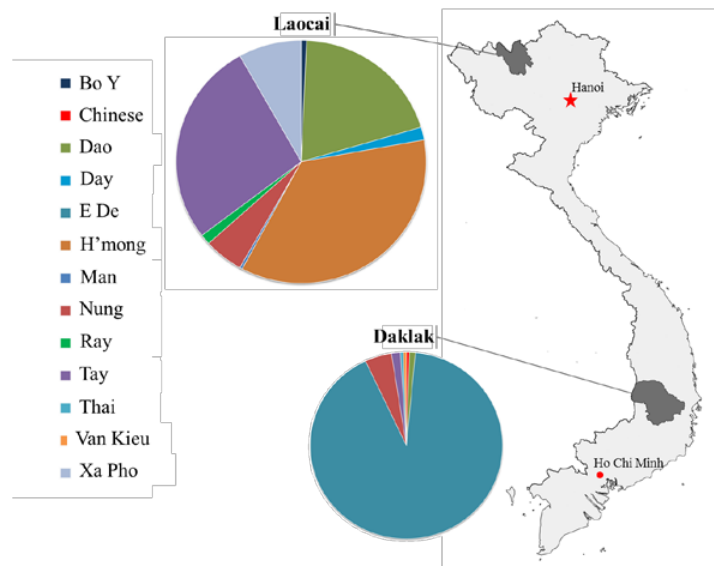
Figure 1. Map of Vietnam showing the geographical location and the frequency of the studied minority ethnic groups residing in Daklak and Lao Cai.